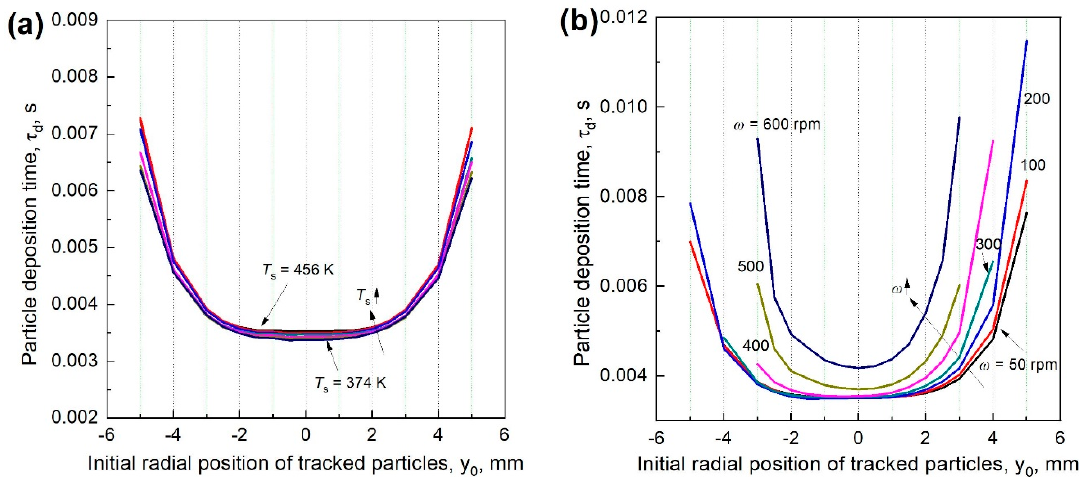
Figure 10. Deposition time of the tracked particles when the stagnation surface is ( a ) in stationary and ( b ) rotates at different speeds.